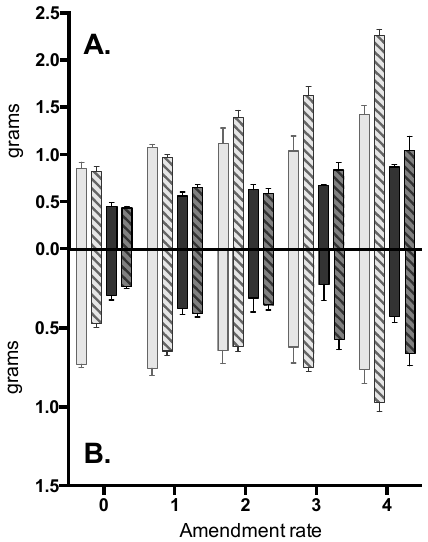
Figure 1. The dry mass of shoots ( A ) and roots ( B ) grown in Freeman (light grey) or Bernhill (dark grey) soils amended with KB- (solid) or wood- (cross-hatched) sourced biochars. Amendment rates are represented as 0–4, which correspond to rates of 0%, 3%, 6%, 16%, and 25% by volume for both biochars, 0%, 0.7%, 1.7%, 3.7%, and 8.6% by mass for wood biochar, and 0%, 0.4%, 1.2%, 2.5%, and 5.8% by mass for KB-sourced biochar.